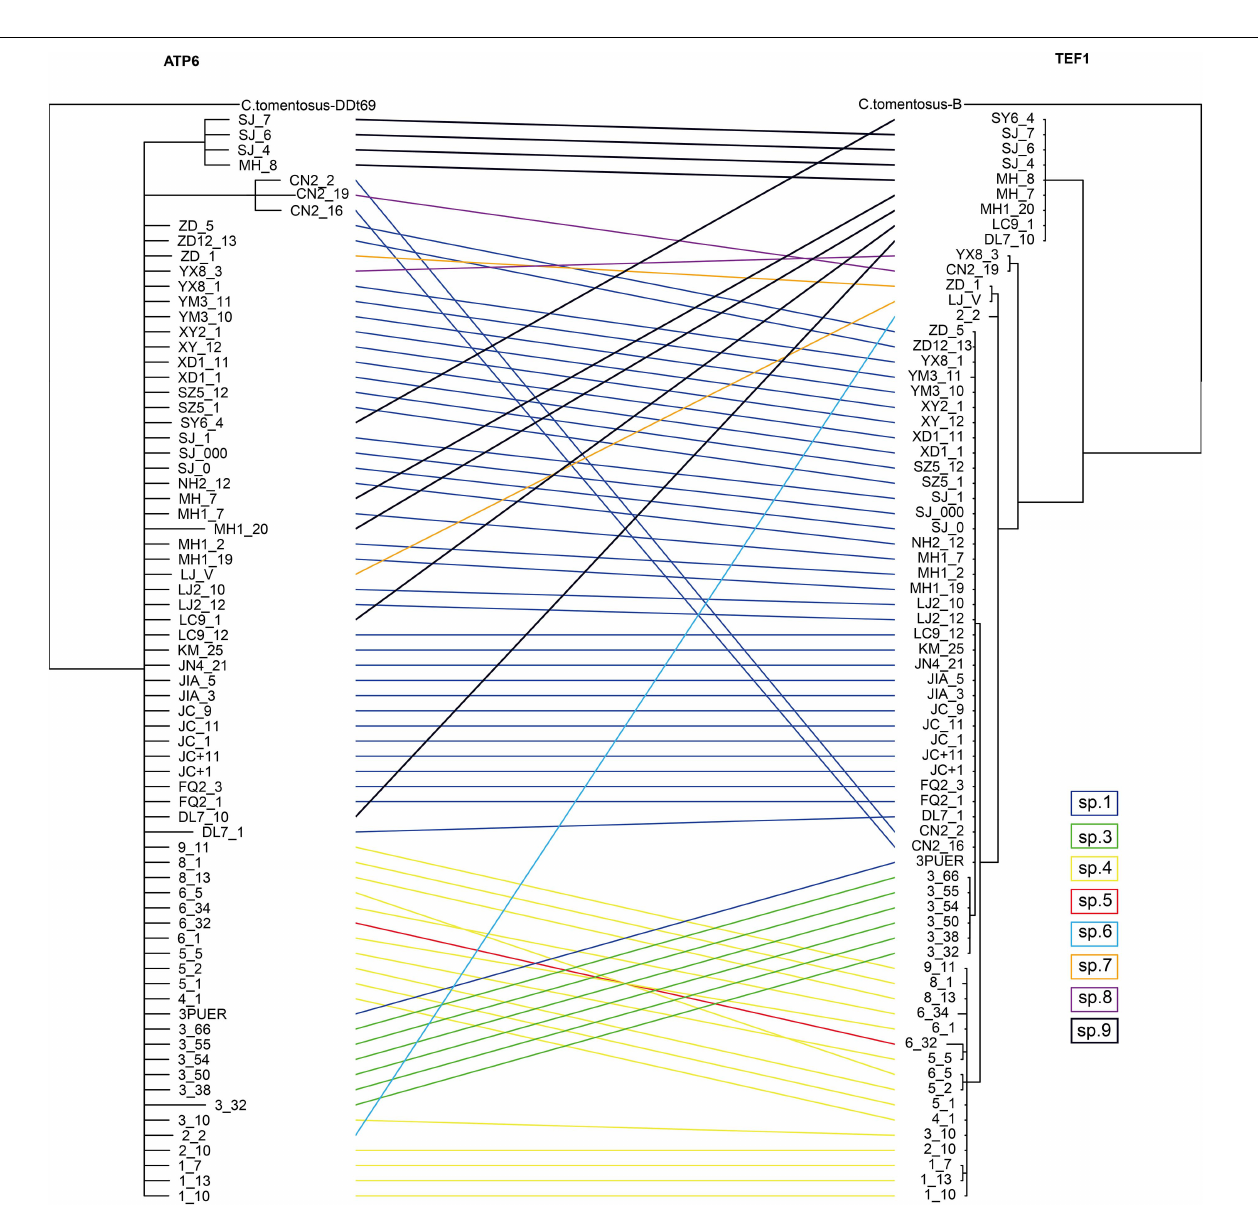
FIGURE 4 | The tanglegram between tef-1 and atp6 phylogenies. The full name can be found in Supplementary Table 2